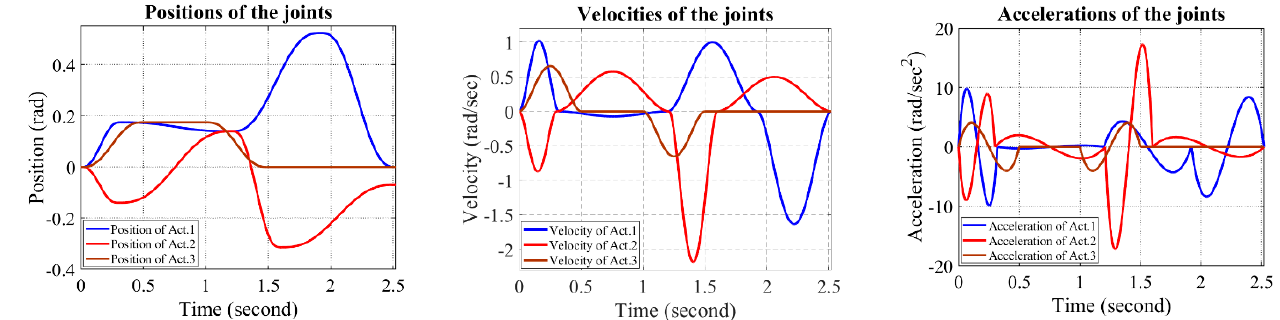
Figure 2. Joints trajectories for a gait cycle.